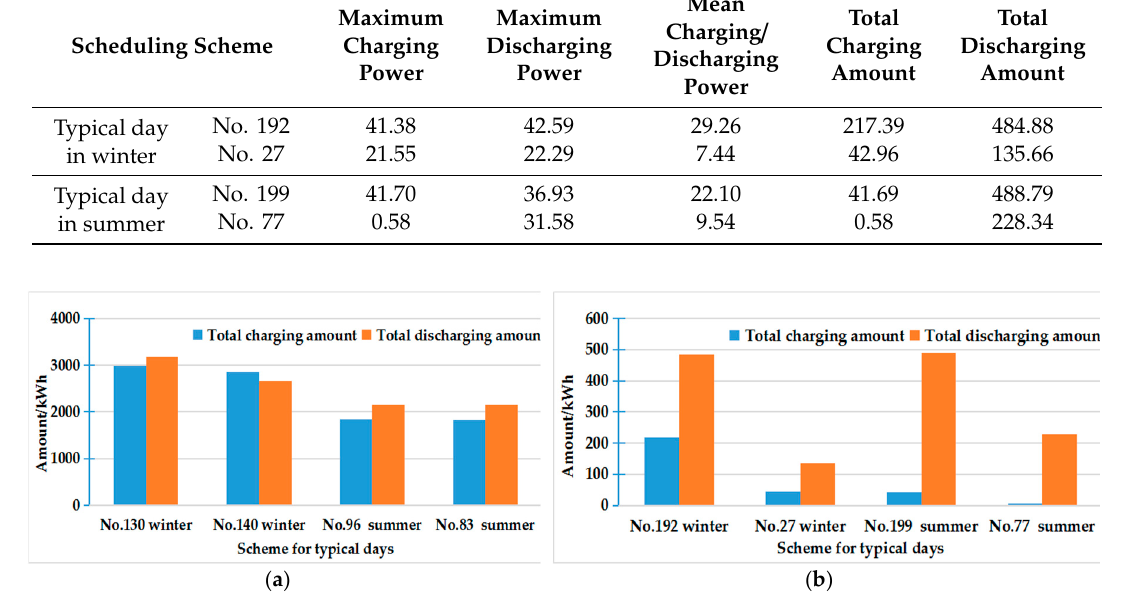
Table 16. Performance of the VESS of CHCS for the typical days in winter / summer. Figure 15. VESS charging/discharging power in best scheduling scheme for RR-microgrid with CHCS. ( a ) A typical day in winter; and ( b ) a typical day in summer.